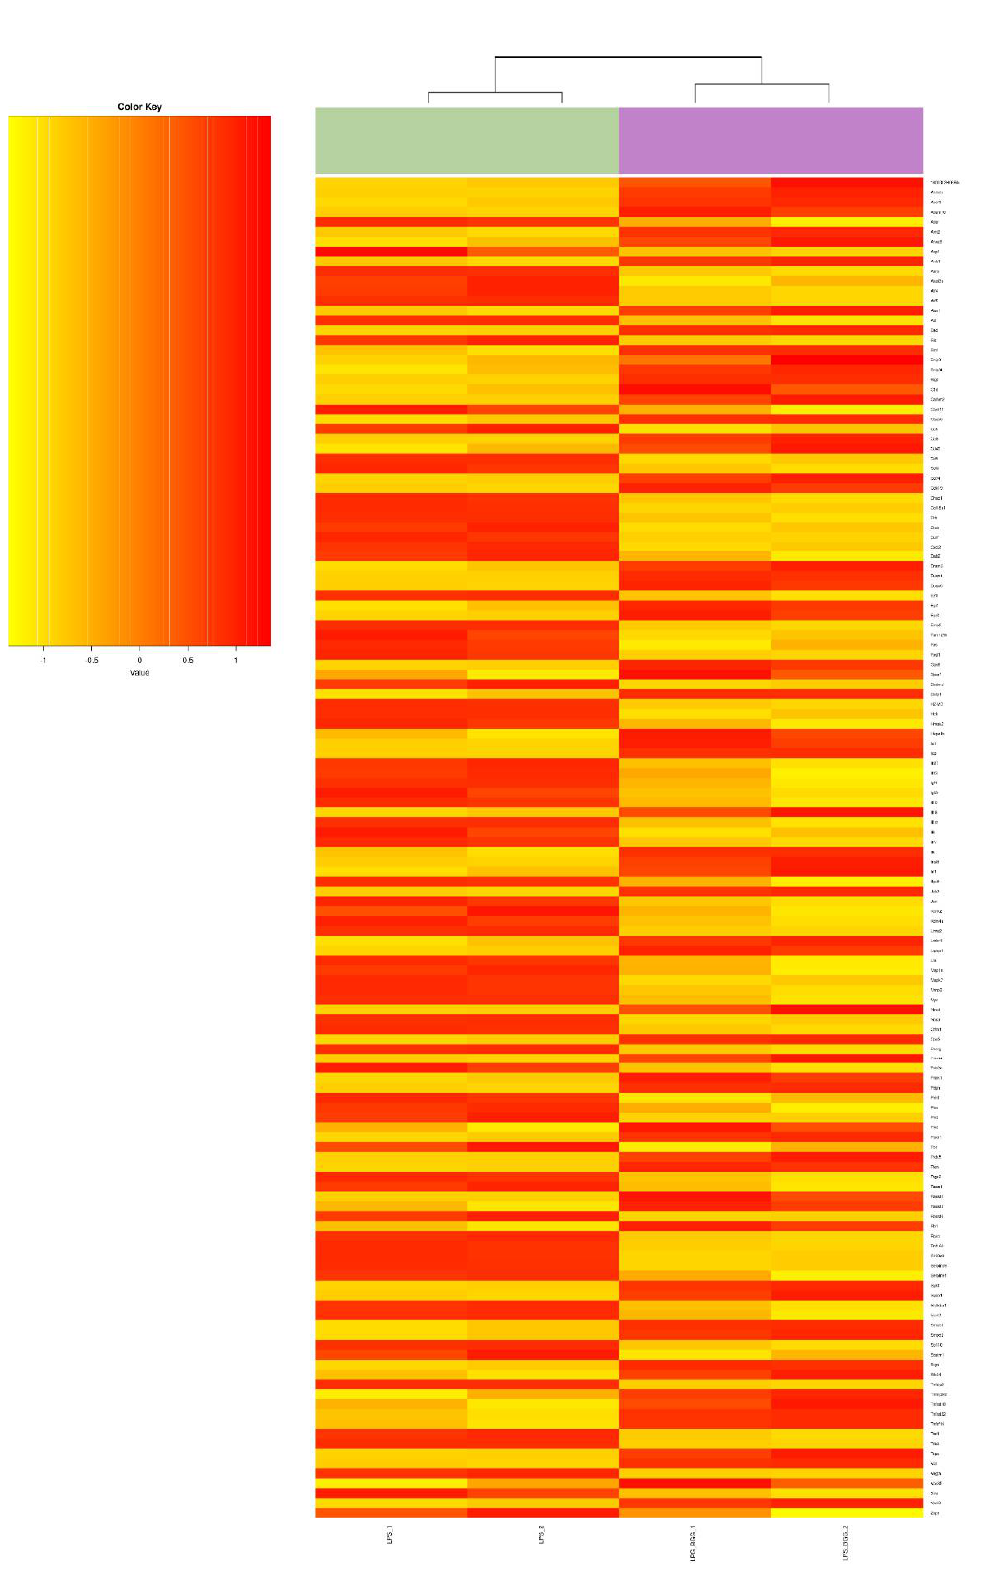
Figure 5. Heatmap represents the genes involved in the cell death pathway from microarray gene expression.